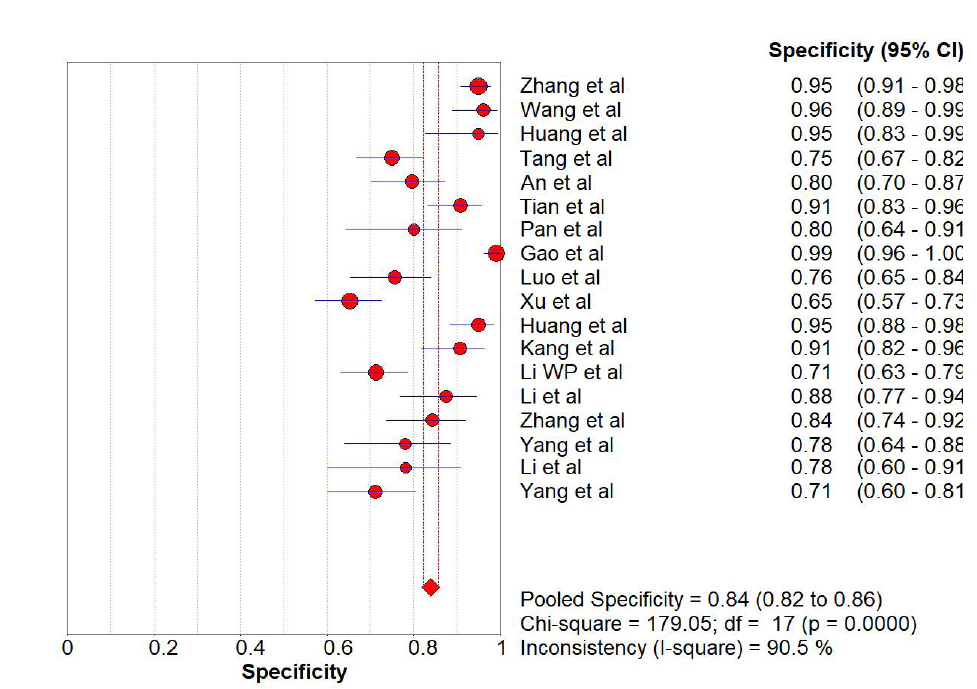
Figure 3: The forest plot of diagnostic specificity for serum Hcy in diagnosis of